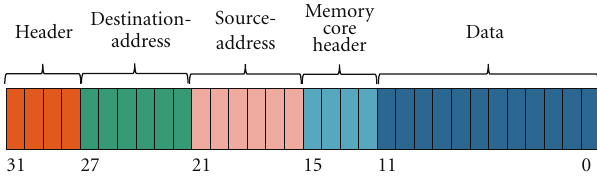
Figure 4: Basic structure of the control packets used for the memory